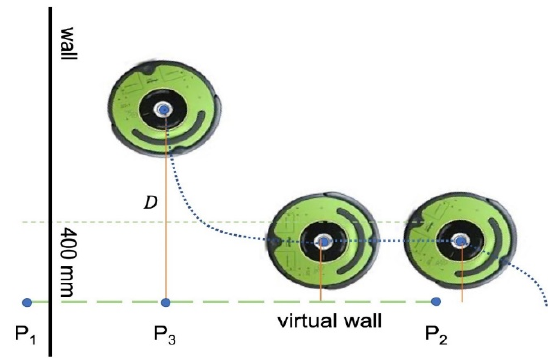
Figure 5. Virtual wall